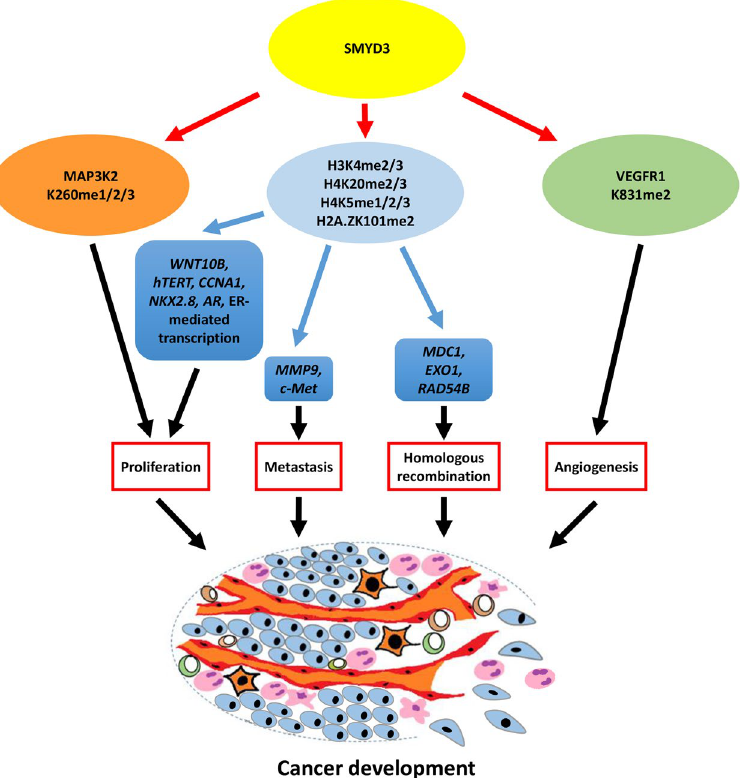
and angiogenesis. Moreover, SMYD3 methylates histones that are widely spread on chromatin to facilitate transcription of target genes. Hence, the high level of SMYD3 stimulates cancer